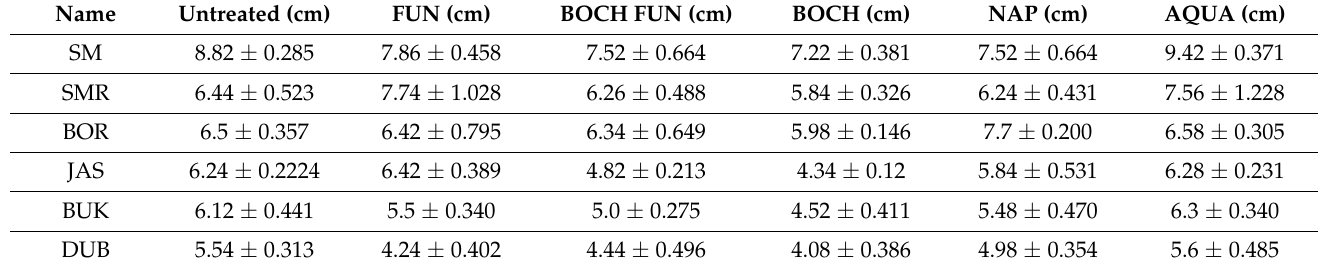
Table 5. Comparison of flame height.